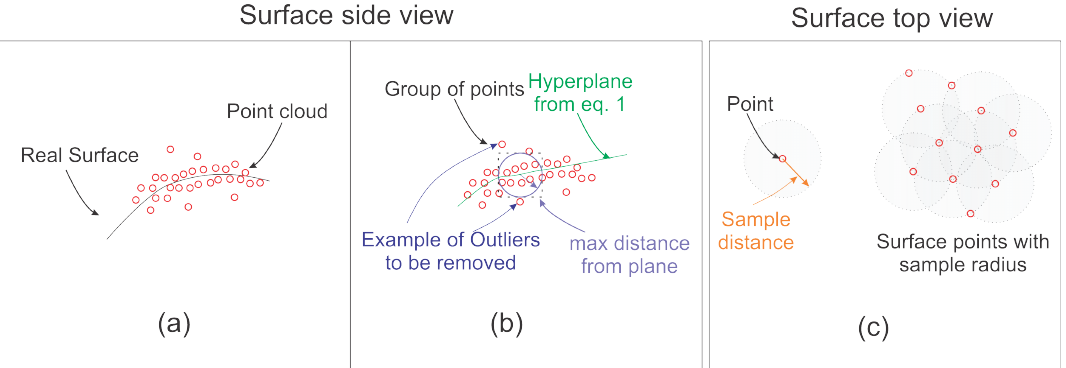
Figure 2. Ilustration of the filtering process ( a ) real surface and reconstruction ( b ) local hyperplane fitting and ( c ) uniform